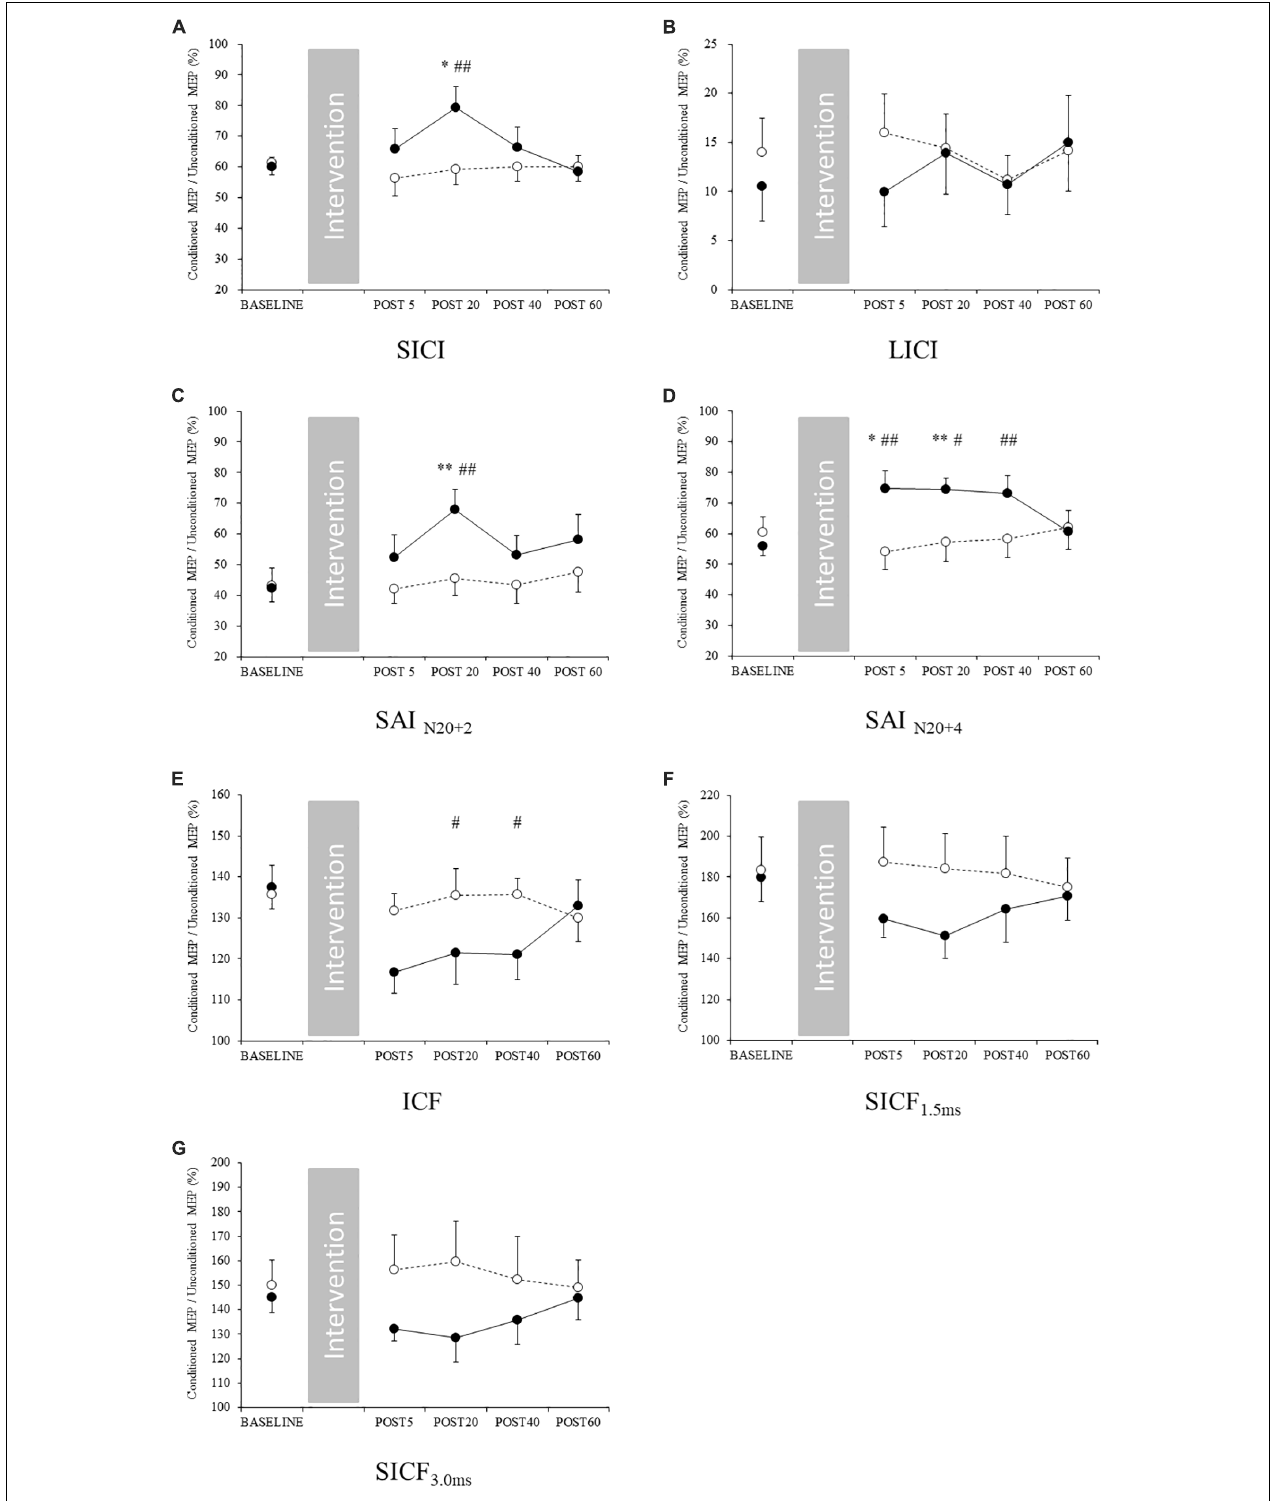
FIGURE 2 | Changes in intracortical circuits of the M1 non-exercised area. Filled and open circles indicate exercise and control conditions, respectively. (A) short-interval intracortical inhibition, (B) long-interval intracortical inhibition, (C) short-latency afferent inhibition N 20 + 2 , (D) short-latency afferent inhibition N 20 + 4 , (E) intracortical facilitation, (F) short-interval intracortical facilitation 1.5 ms, and (G) short-interval intracortical facilitation 3 ms. ∗ p < 0.05 compared with baseline, ∗∗ p < 0.01 compared with baseline, and # p < 0.05 compared with control conditions, ## p < 0.01 compared with control conditions.